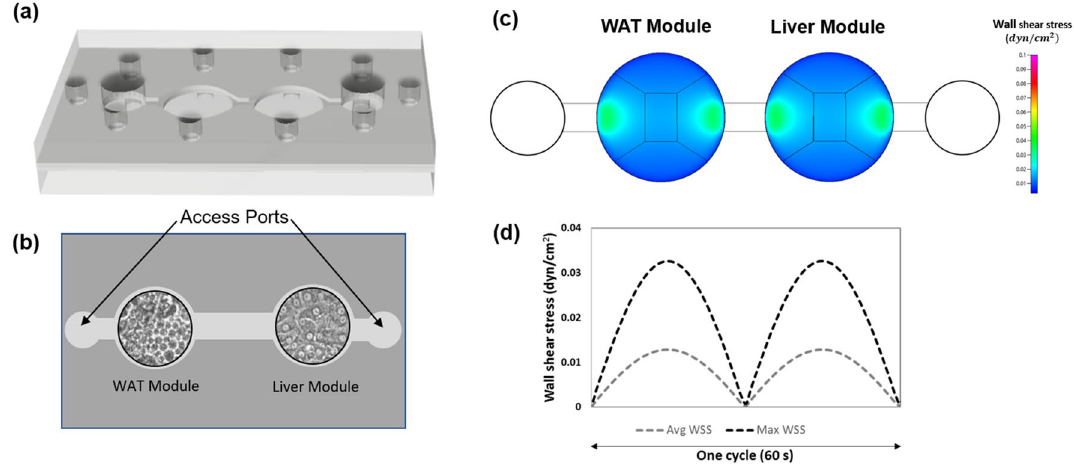
Figure 3. System fabrication and characterization. ( a ) Schematic of 2-chamber microfluidic housing. ( b ) Compartments of 2-chamber housing containing white adipocyte and hepatocyte modules. ( c ) Maximum shear stress distribution. ( d ) Shear stress quantification over one rocker cycle.